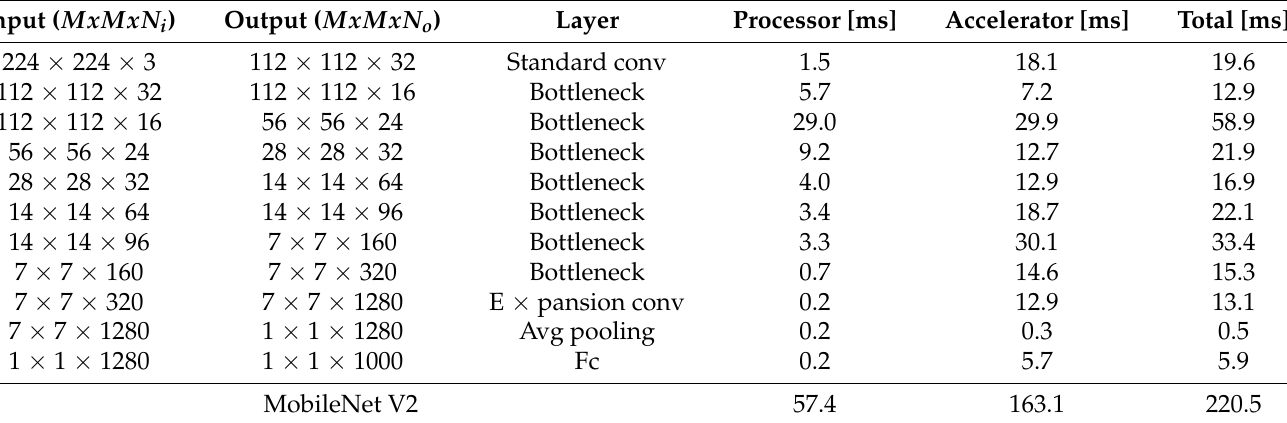
Table 9. Execution time of each layer of MobileNet V2 on the accelerator.